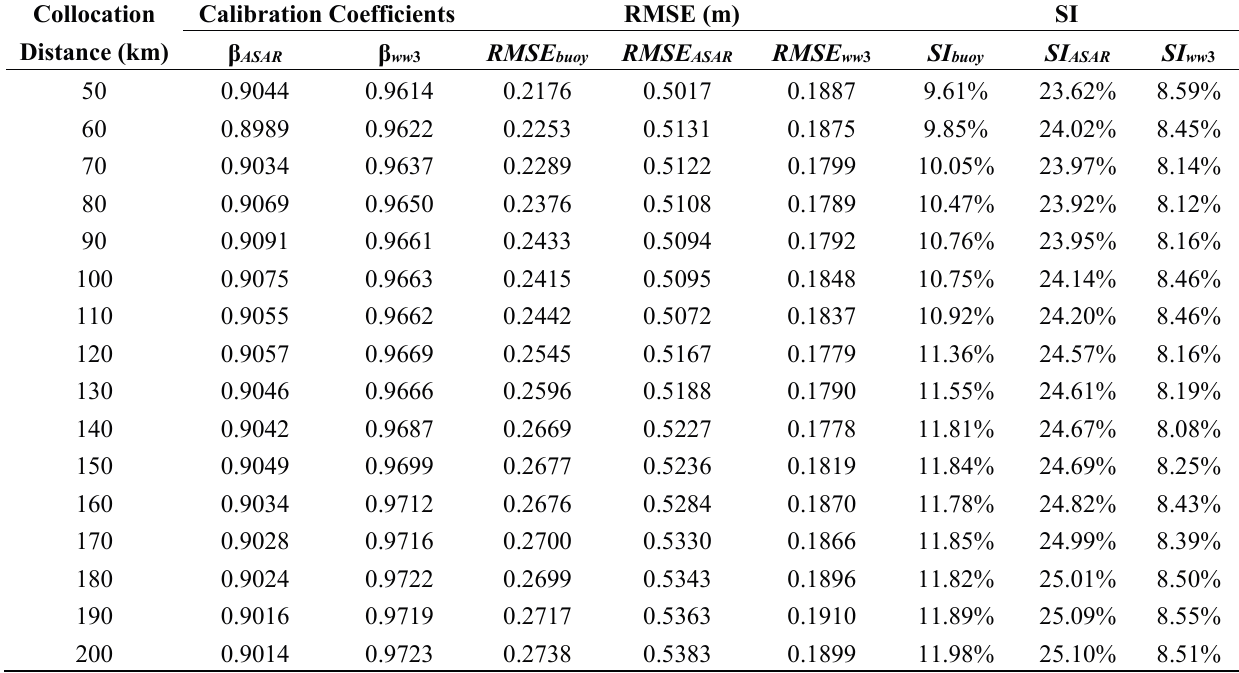
Table 2. As in Table 1, but for collocated datasets with the 54 buoys only in the deep and open